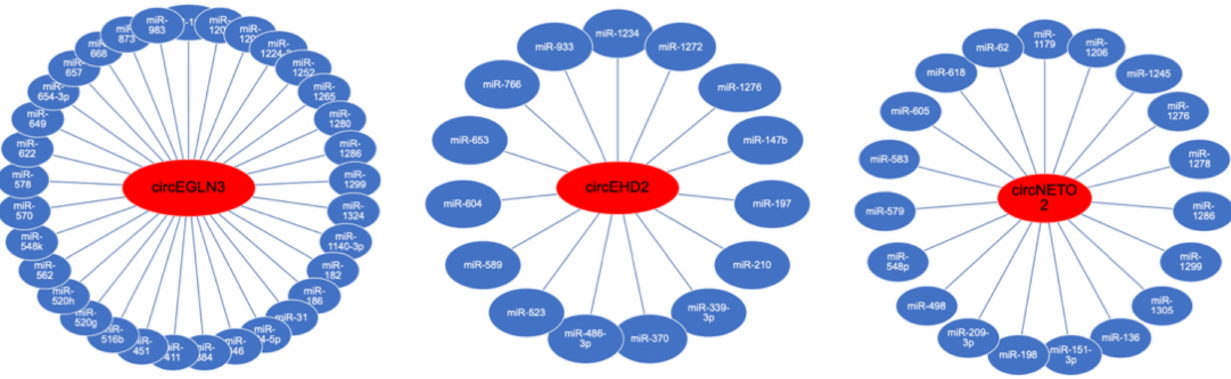
Figure 5. The circRNAs circEHD2, circEGLN3, and circNETO2 have multiple putative binding sites for